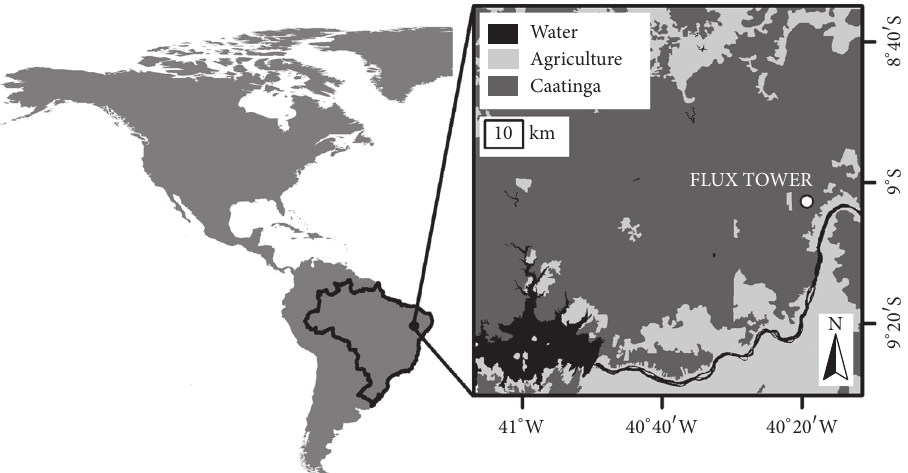
Figure 1: Location of the Flux tower installed in an area of Caatinga at Embrapa Semi´arido, which is a research station of the state of Pernambuco, Brazil. Land use map source: